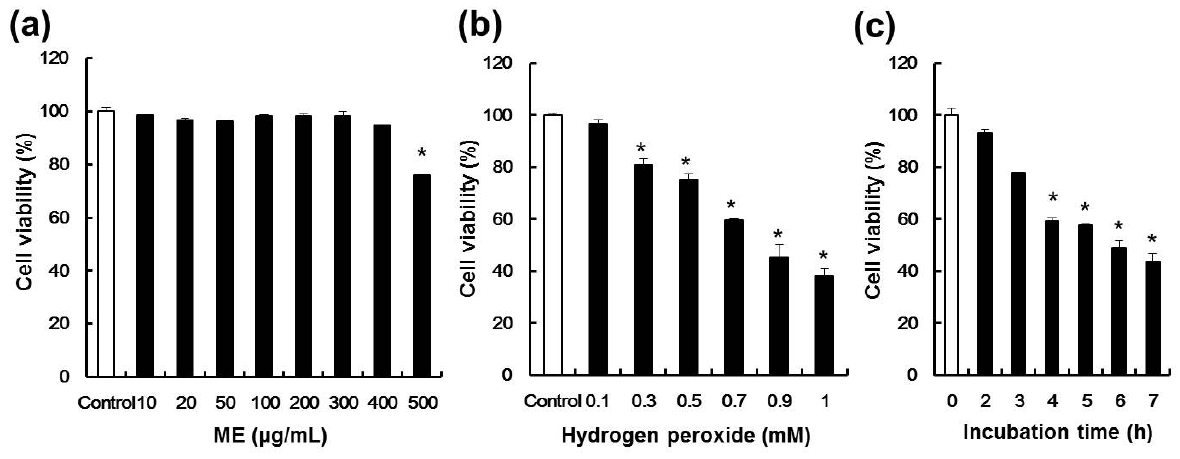
Figure 2. Viability of pancreatic MIN6N β -cells treated with ME and hydrogen peroxide. ( a ) Cell viability of pancreatic MIN6N β -cells treated with various concentrations of ME. ( b ) Cell viability of pancreatic MIN6N β -cells treated with various concentrations of hydrogen peroxide. ( c ) Cell viability of pancreatic MIN6N β -cells treated with different exposure time with 0.7 mM hydrogen peroxide. Data represent the mean ± SE of three independent experiments. Significance of the differences were compared with the control at * p < 0.05 by Student’s t